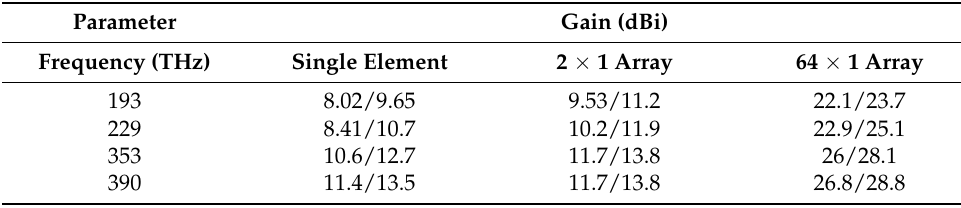
Table 3. Summary of the overall results of gain and